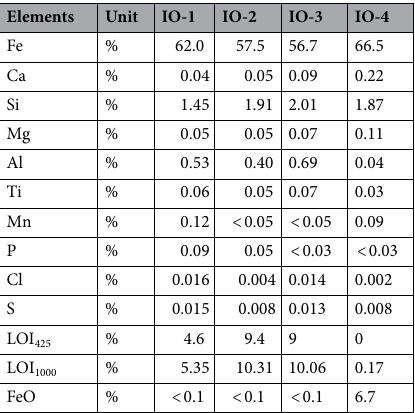
Table 1. Element concentrations and loss on ignition (LOI) in the four types of iron ores (IO) used in this study * . *Cr, Cu, K, Ni, Pb, Sn, V, Z were measured at below detection limit of 0.05% for all samples.